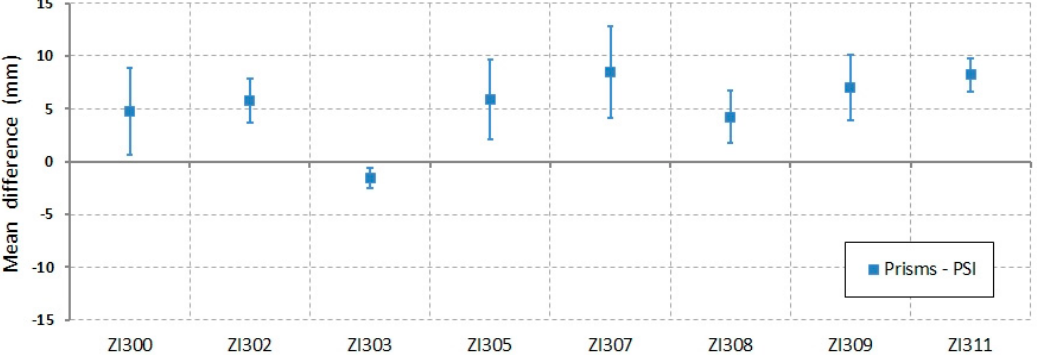
Figure 18. Mean difference and the standard deviation between the measurements of the two methods (Prisms minus PSI) for the 34 points analysed in the Selinha dike.